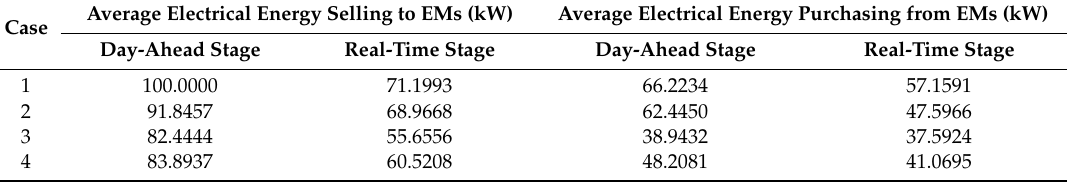
Table 4. Average electrical energy selling to and purchasing from electricity markets (EMs) in Cases 1–4 for the typical winter day.